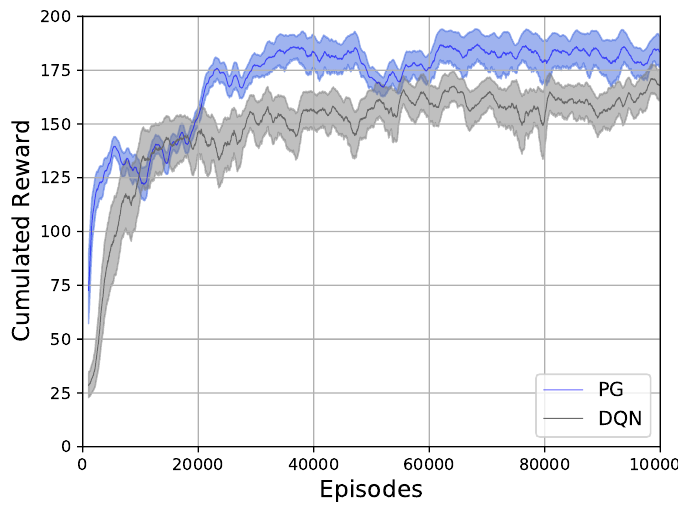
Figure 7. Convergence of PG and DQN